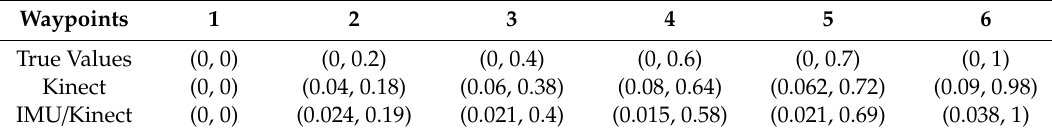
Table 5. Control points’ coordinates in the straight line experiment (in meters).